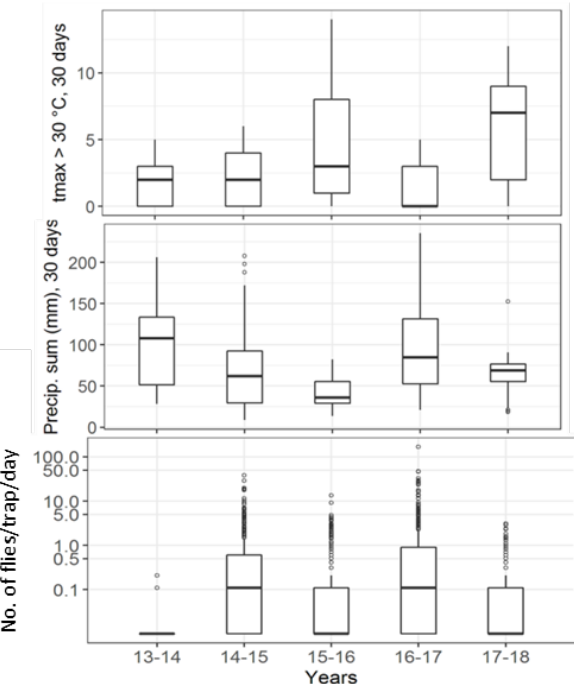
Figure 8. Late spring captures: (top) the number of days when tmax > 30 °C and (middle) precipitation sum (mm) in the 30 days before the traps were emptied for each trap deployment; (bottom) captures/day from each trap deployment. Both panels are per D. suzukii -year. Note: log-scaled y-axis on the bottom panel.